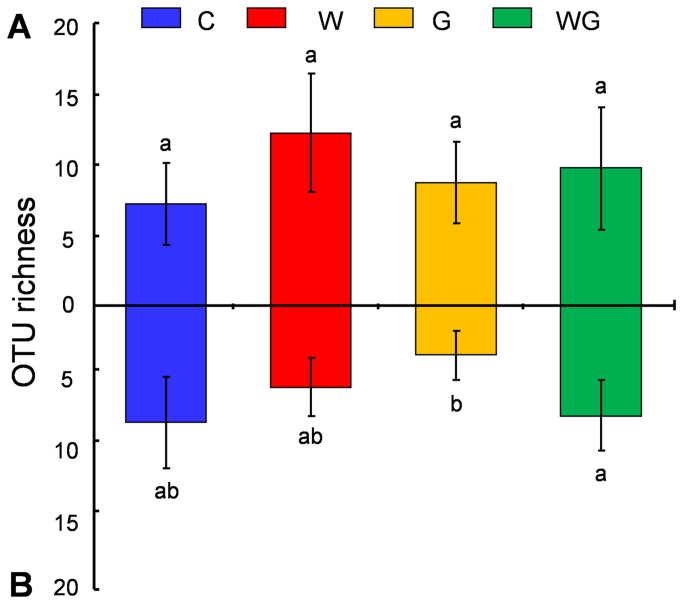
AM fungal OTU richness (A) in soil and (B) in roots among the four treatments.Bars without shared letters indicate significant difference at P < 0.05. Bars are standard deviations of the means (n = 4). Abbreviations: C, no-warming with no-grazing; W, warming with no-grazing; G, no-warming with grazing; WG, warming with grazing.